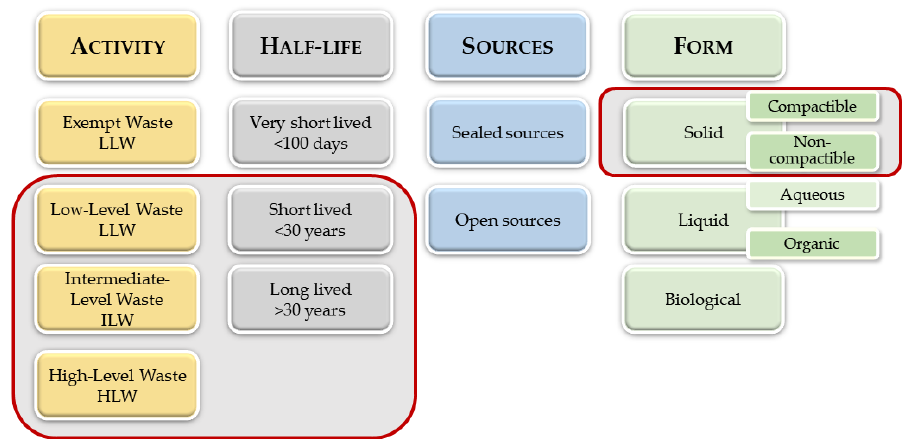
Figure 3. Di ff erent categorizations of radioactive waste based on [27]; radioactive waste containing graphite is